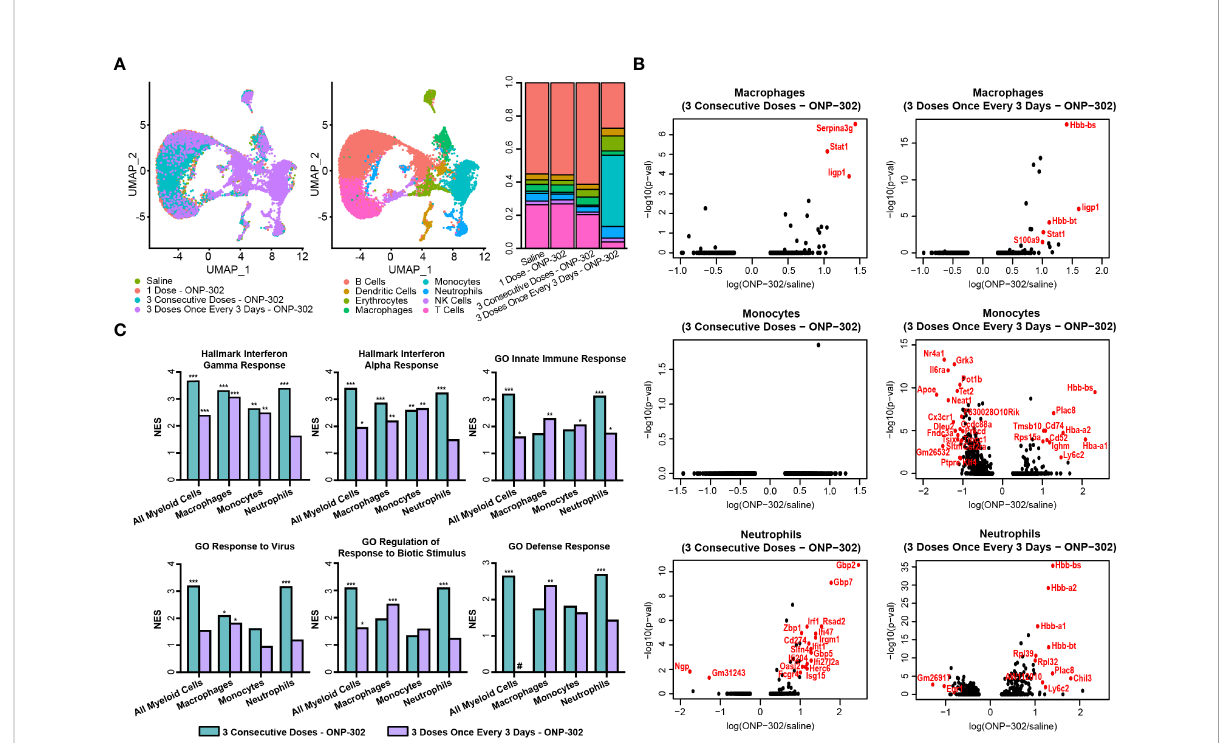
FIGURE 1 Single cell RNASeq analysis of ONP-302-induced gene expression. Naïve female C57BL/6 mice (n = 3 per group) were treated with saline or ONP-302 (1.0 mg/dose in 200 m L of saline) either once, three days consecutively (days 0, 1, and 2), or every three days (Days 0, 3, and 6) via i.v. injection. Twenty-four hours after the last injection, spleens were collected to assess the transcriptome via single cell RNASeq. (A) The distribution of cells within the spleen in response to saline and each of the ONP-302 dosing schemes is compared. (B) The ONP-302-induced changes in gene expression by macrophages, monocytes, and neutrophils is compared. Red genes have a log fold change > 1 and a p -value < 0.05. (C) The signaling pathways induced by the ONP-302 treatment relative to saline treatment alone as measured through Gene Set Enrichment Analysis (GSEA), NES = normalized enrichment score, * q < 0.1, ** q < 0.01, *** q < 0.001, # pathway was not enriched in this